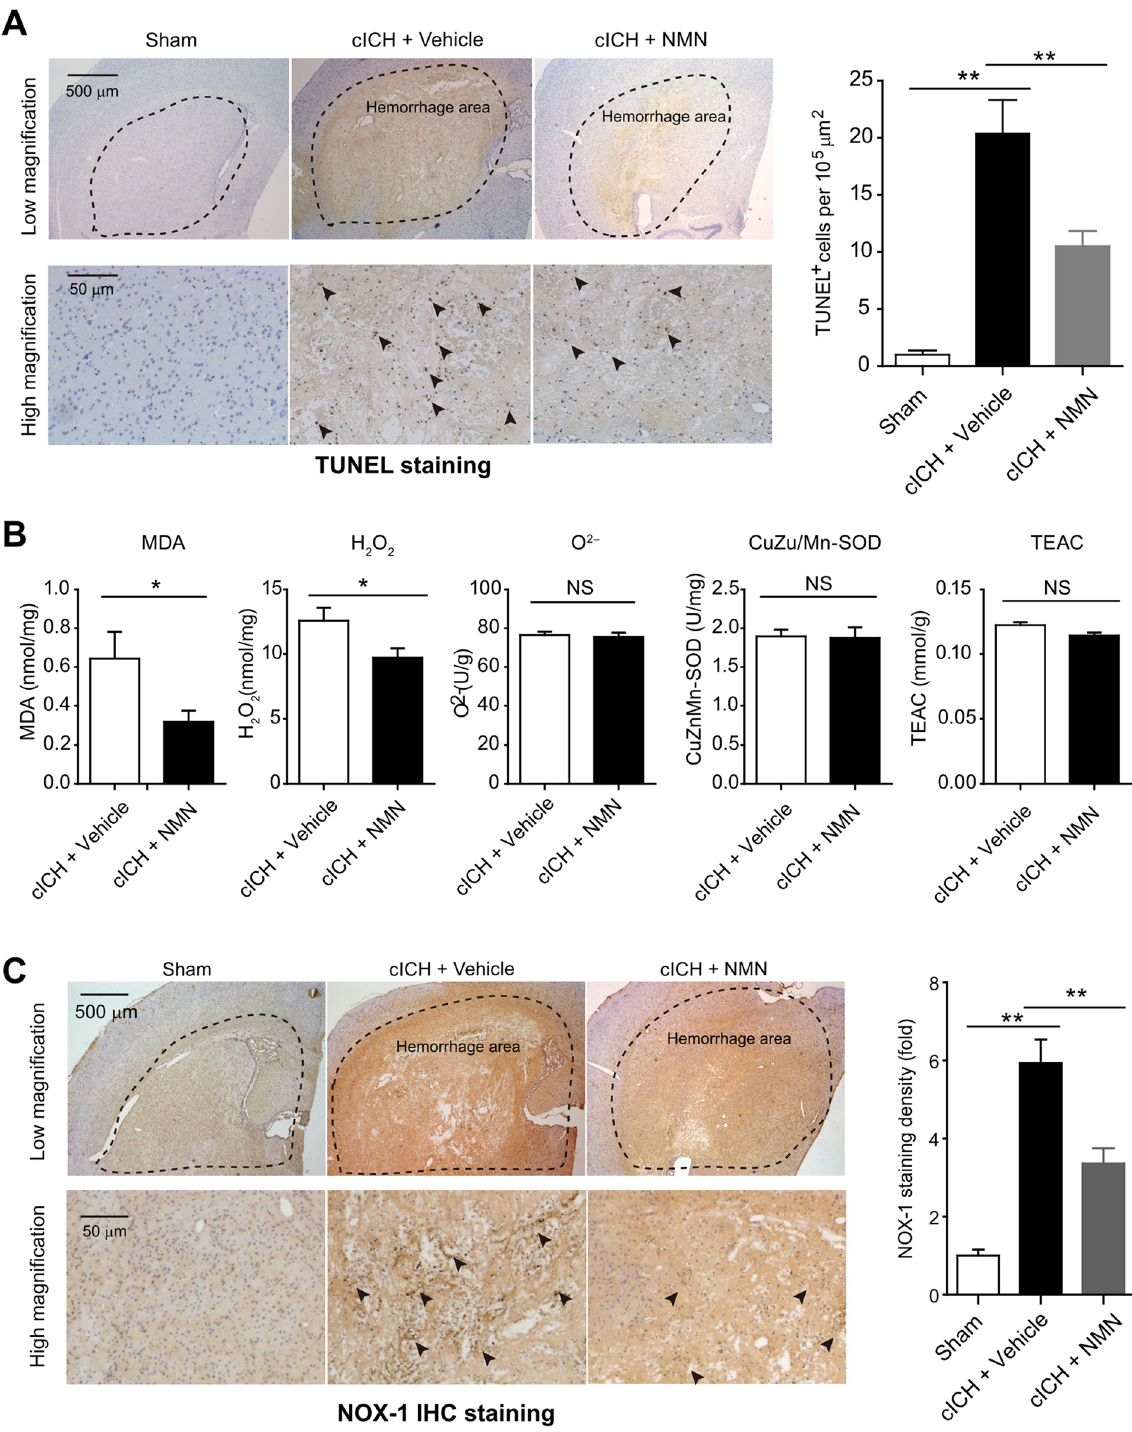
Figure 2. Effects of NMN on brain cell death and oxidative stress in mouse cICH model. ( A ) Representative images and quantitative analysis of TUNEL staining at 24 hours post cICH. ** P < 0.01, n = 5 per group. ( B) Oxidative parameters in hemorrhagic brain tissue, including MDA, H 2 O 2 , O 2 − , CuZn/Mn-SOD, total- antioxidant activity, were determined at 24 hours post cICH. * P < 0.05, n = 6 per group. ( C ) Representative images and quantitative analysis of NOX-1 immunohistochemistry staining at 24 hours post cICH. ** P < 0.01, n = 5 per